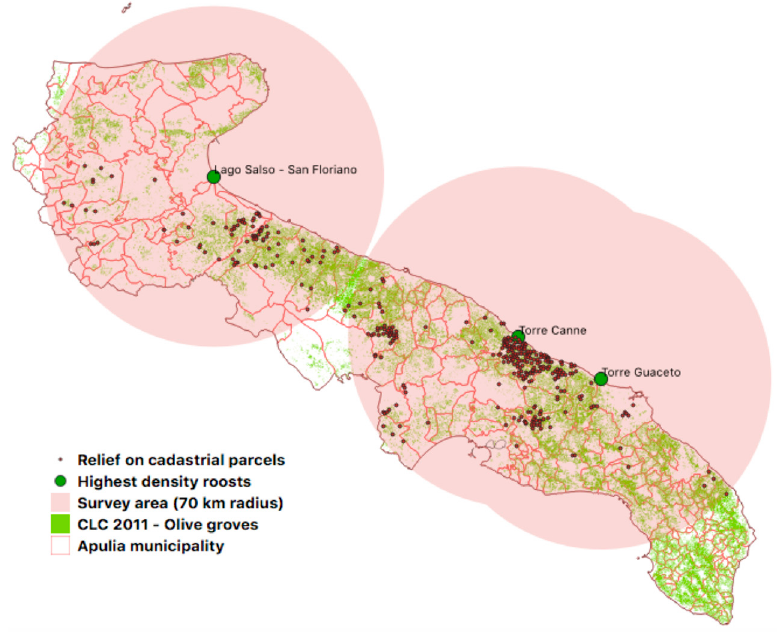
Figure 4. Identification of roosts and inspection areas within a 70 km radius.